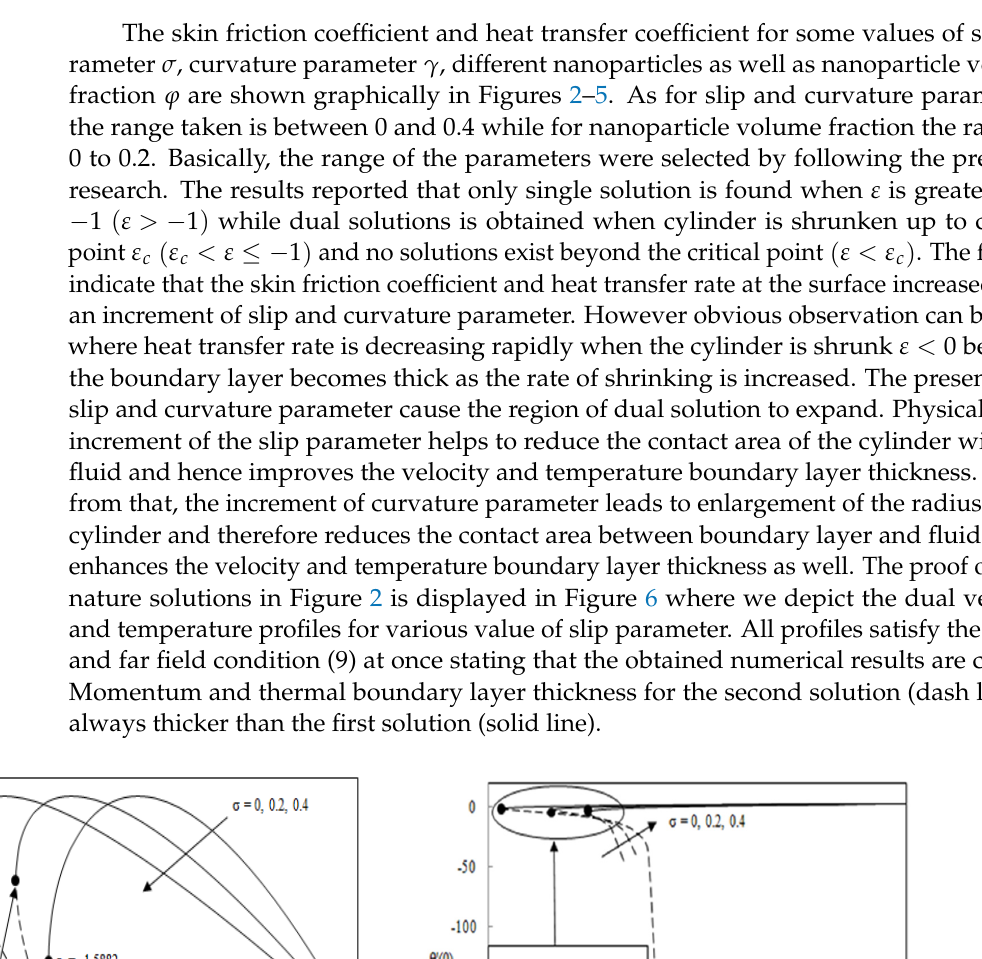
( b ) Figure 4. Skin friction 𝑓 (cid:4593)(cid:4593) (cid:4666) 0 (cid:4667) ( a ) and heat transfer coefficient (cid:3398)𝜃 (cid:4593) (cid:4666) 0 (cid:4667) ( b ) vs. 𝜀 for particular nano ‐ particles.